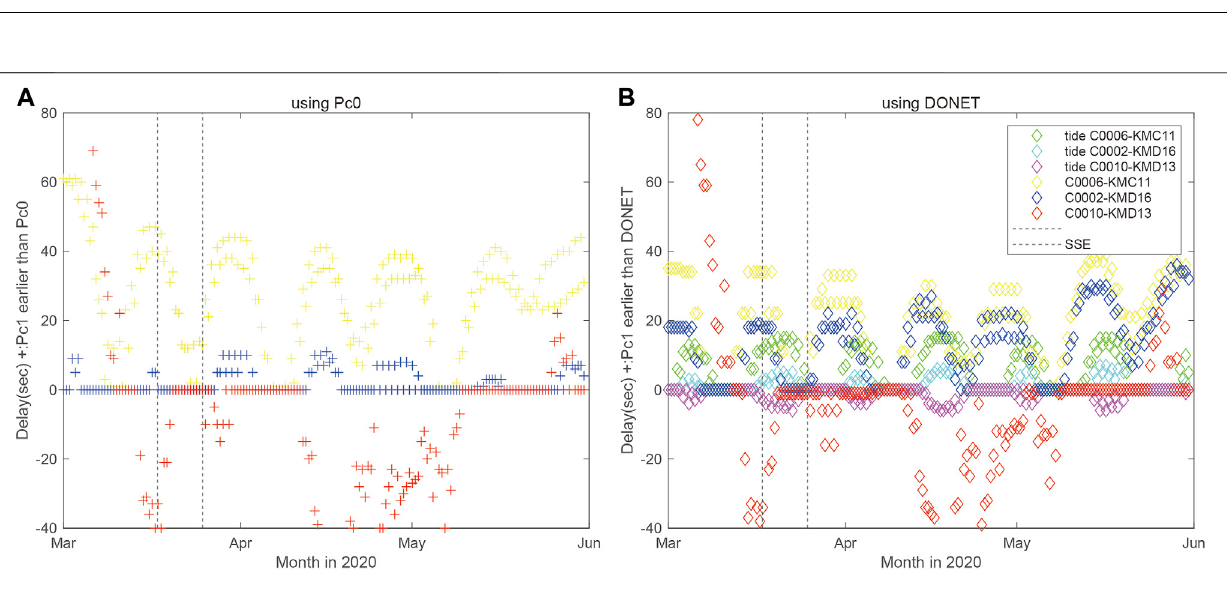
various kinds of the observation data provided from the satellites, pro fi ling fl oats, and ships. The hourly inputs of bottom pressure, temperature, salinity, and ocean current data are used for the analyses described in Oceanic fl uctuation impact on the sea fl oor Section. The bottom pressure of JCOPE-T DA is calculated from the water density from sea surface to bottom and atmospheric pressure at sea surface. Temporal variation of bottom pressure variations calculated by JCOPE-T DA without external tidal forcing is represented as